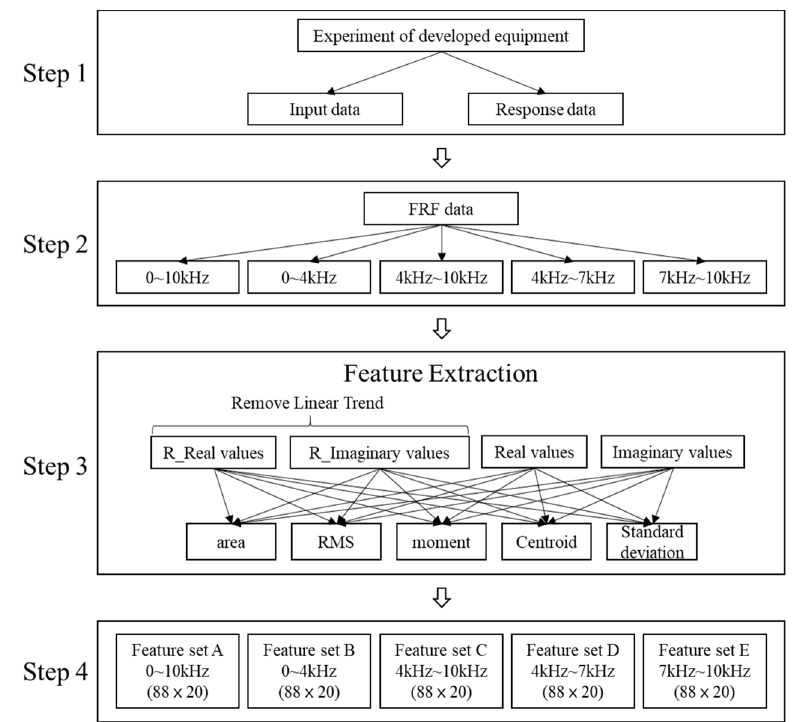
Figure 7. Procedure of feature extraction from experiment of developed equipment.